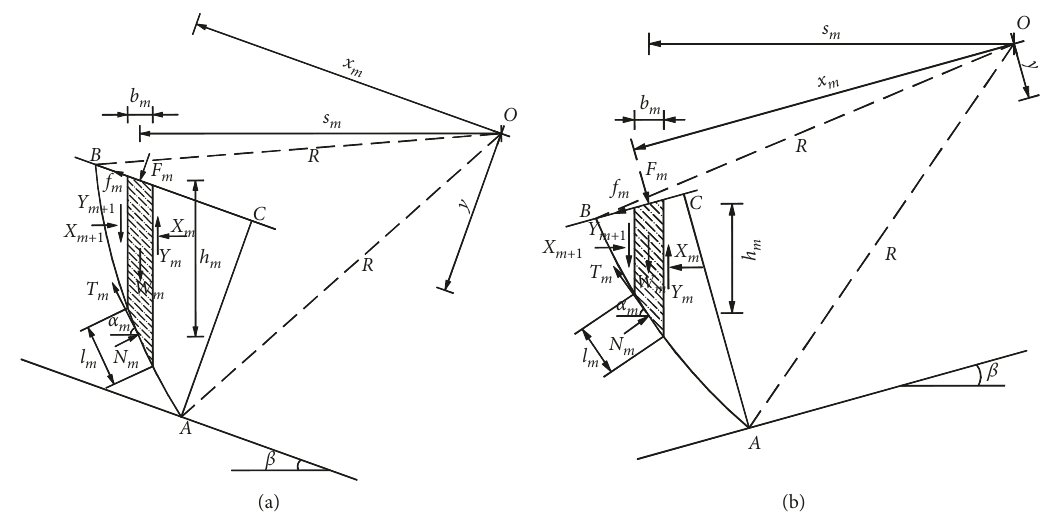
Figure 3: The Bishop mechanical model of up-dip and down-dip mining when coal dip is β .